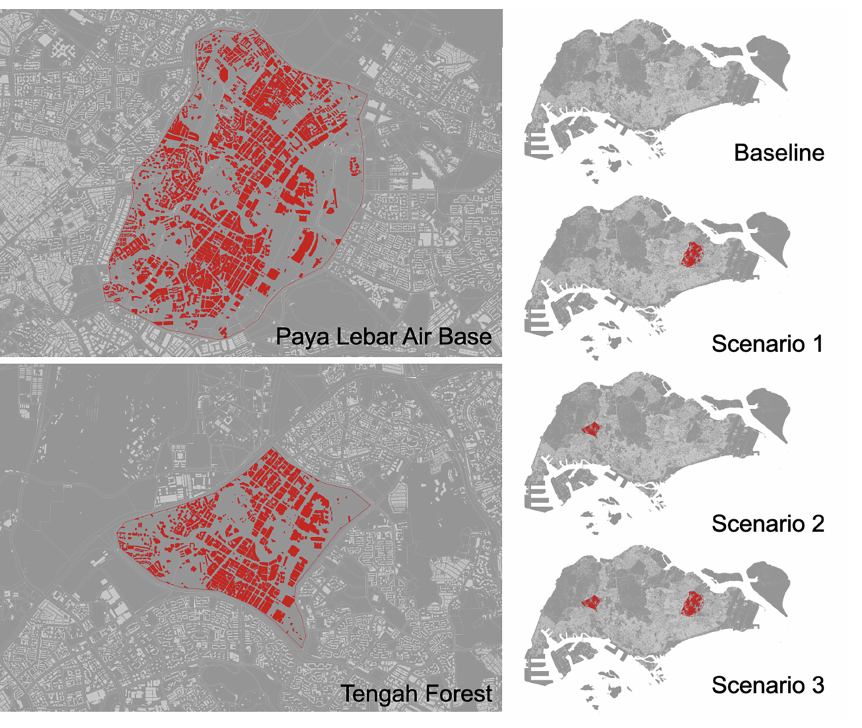
Figure 13. Illustration of the “what-if” scenarios. The newly added built-ups were created only for testing purposes.